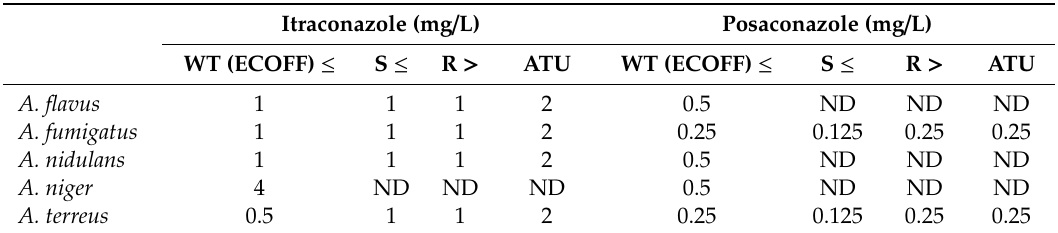
Table 2. ECOFFs and clinical breakpoints for itraconazole and posaconazole against Aspergillus spp. according to the EUCAST breakpoint table v 10.0, 2020 [33].